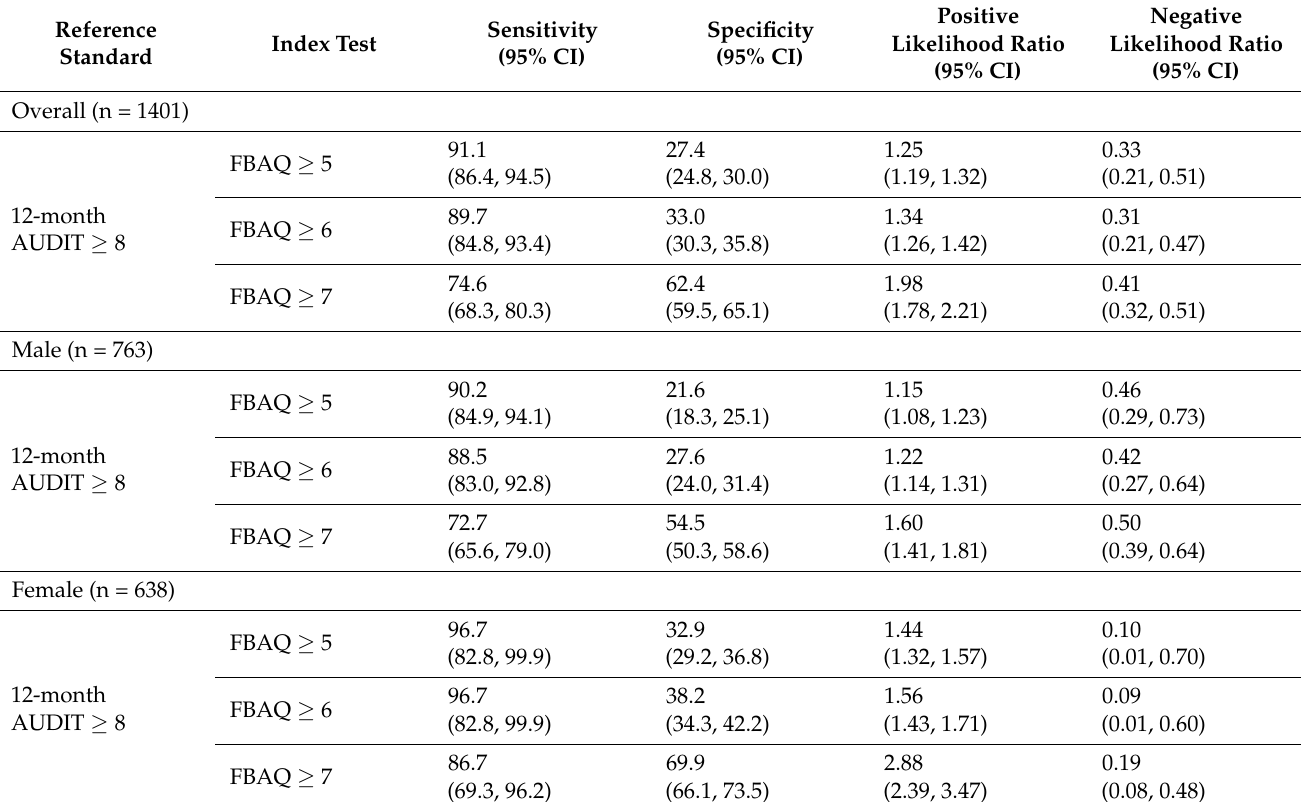
Table 4. Comparative diagnostic accuracy of the FBAQ score with a reference standard (12-month